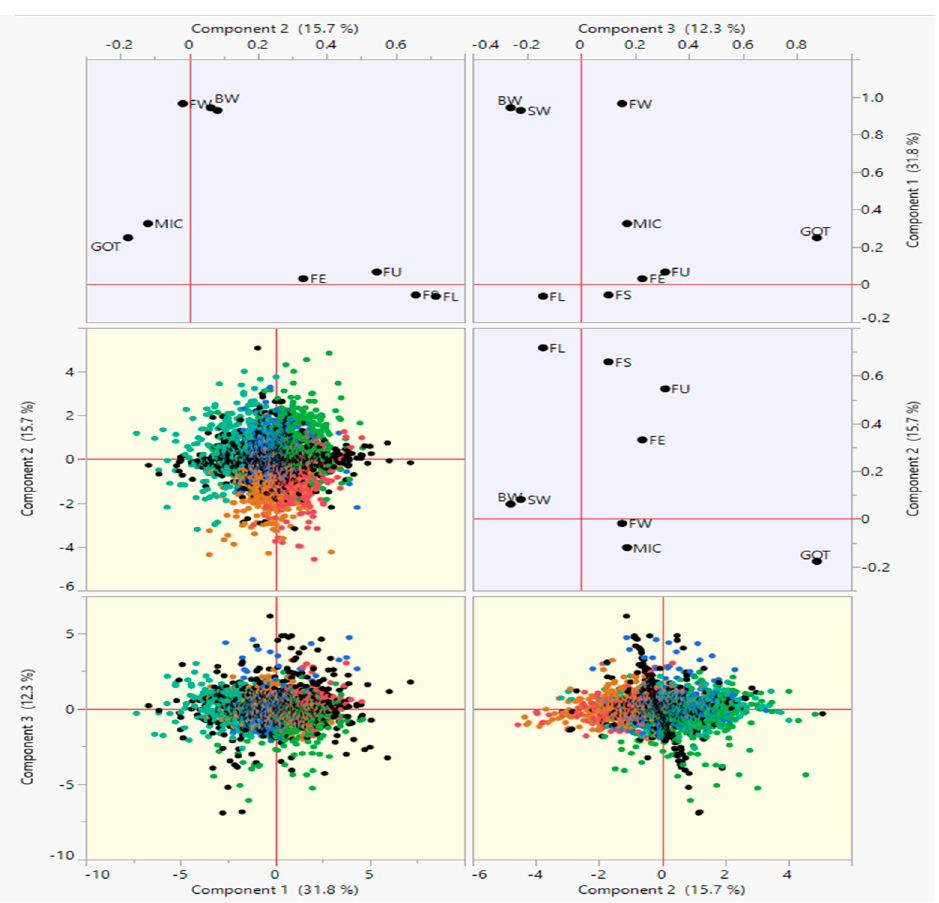
Figure 5. Scatterplot of PC1, PC2, and PC3 displaying the contribution of different